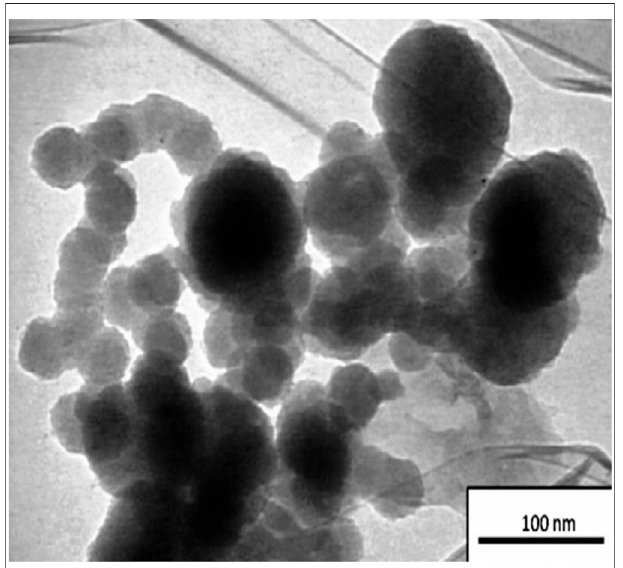
FIGURE 4 | HRTEM of synthesized Cu-Ni nanoparticles.